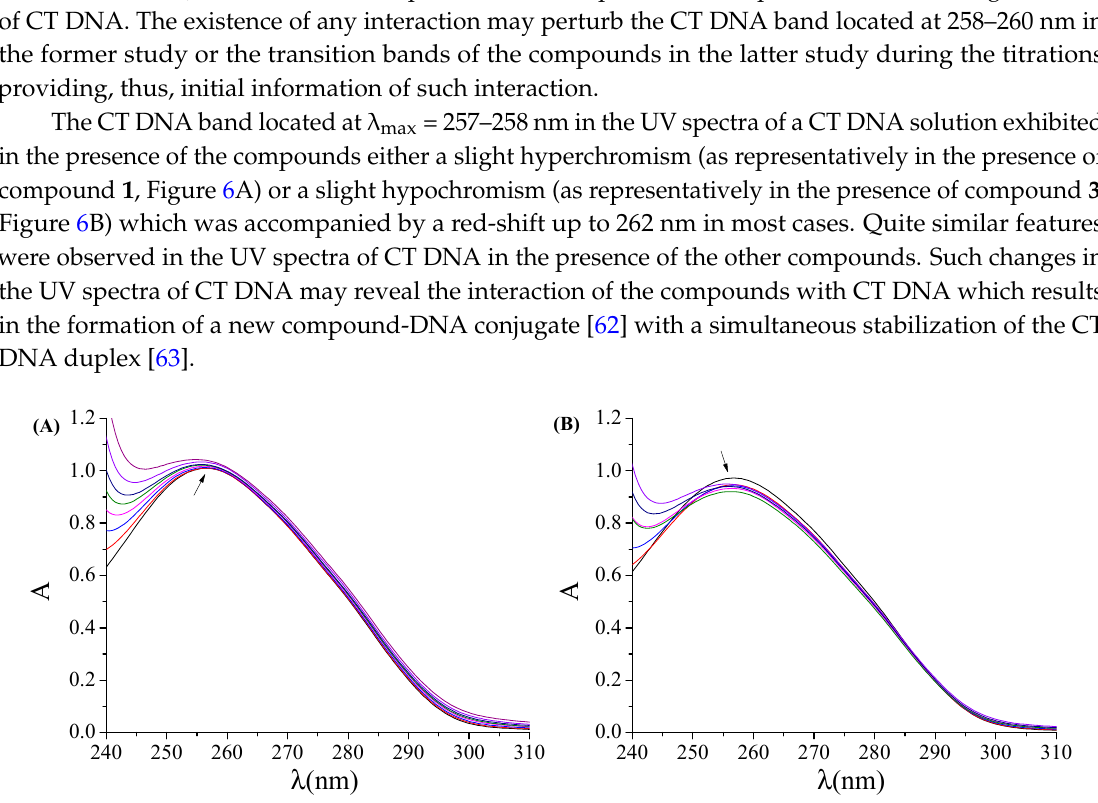
Figure 6. UV spectra of CT DNA in buffer solution (150 mM NaCl and 15 mM trisodium citrate at pH 7.0) in the absence or presence of increasing amounts of ( A ) compound 1 ([DNA] = 0.155 mM) and ( B ) compound 3 ([DNA] = 0.147 mM). The arrows show the changes with increasing amounts of the compounds.